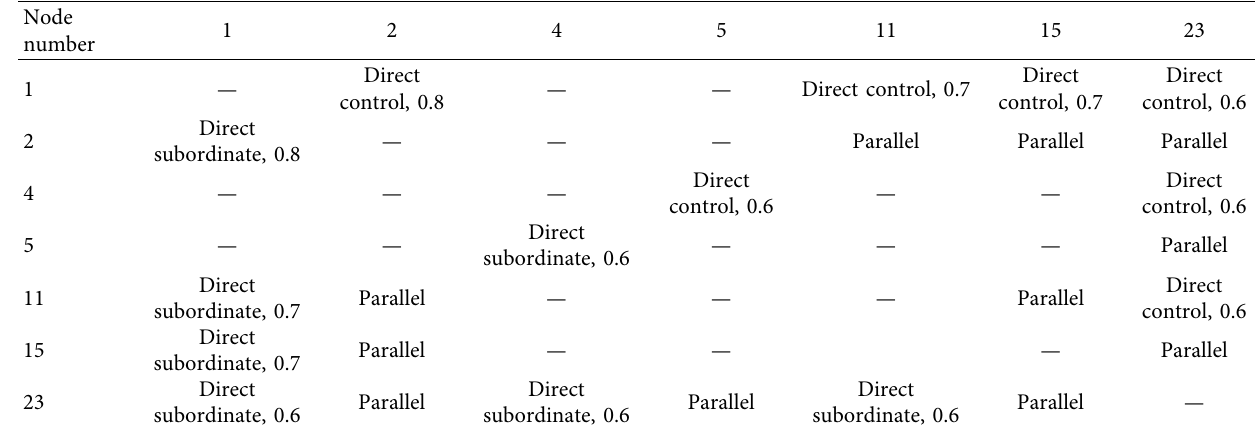
Table 2: Relevance of nodes.